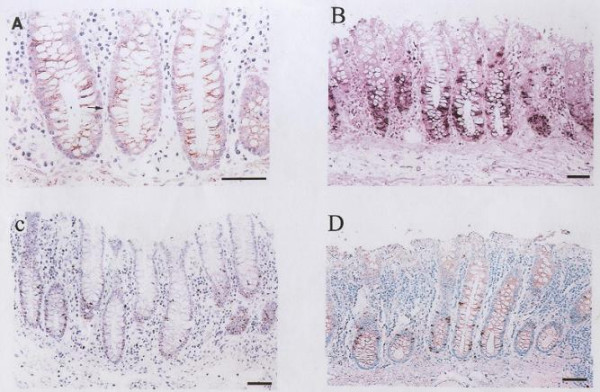
Normal colonic mucosa showing positive nuclear immunostaining for: (a) cyclin D1, (b) ISH of histone H3 mRNA, (c) Ki-67 and (d) cyclin A